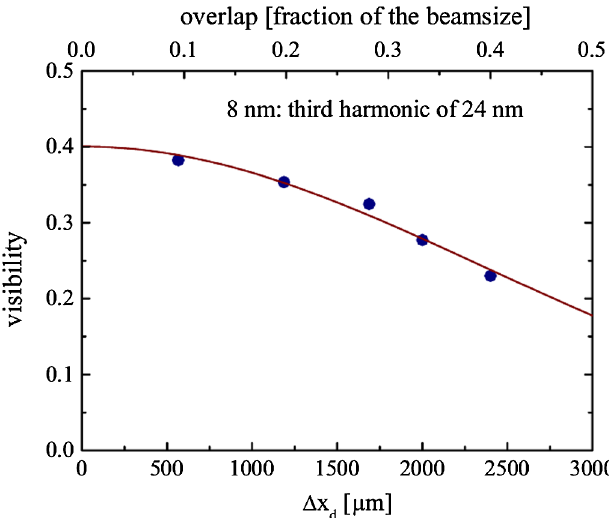
FIG. 11. Spatial coherence of the third harmonic at (cid:1) ¼ 8 nm .